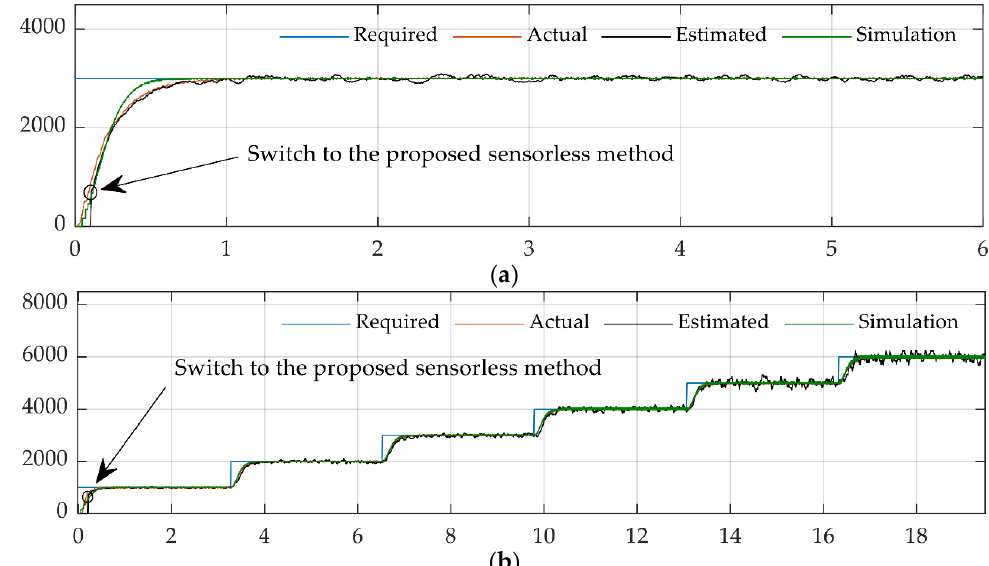
Figure 4. Illustration of difficulty following discontinuous step commands using cascade control structure to provide sensorless speed control. Speed (in revolutions per min) on the ordinates versus time in sec on the abscissa. ( a ) Comparison between the speeds obtained from the measurement and simulation, with a required speed of 3000 rpm (Figure 24 in reference [24]). ( b ) Figure 26. Comparison between the speeds obtained from the measurement and simulation, with stepped changes of required (Figure 26 in [24]).